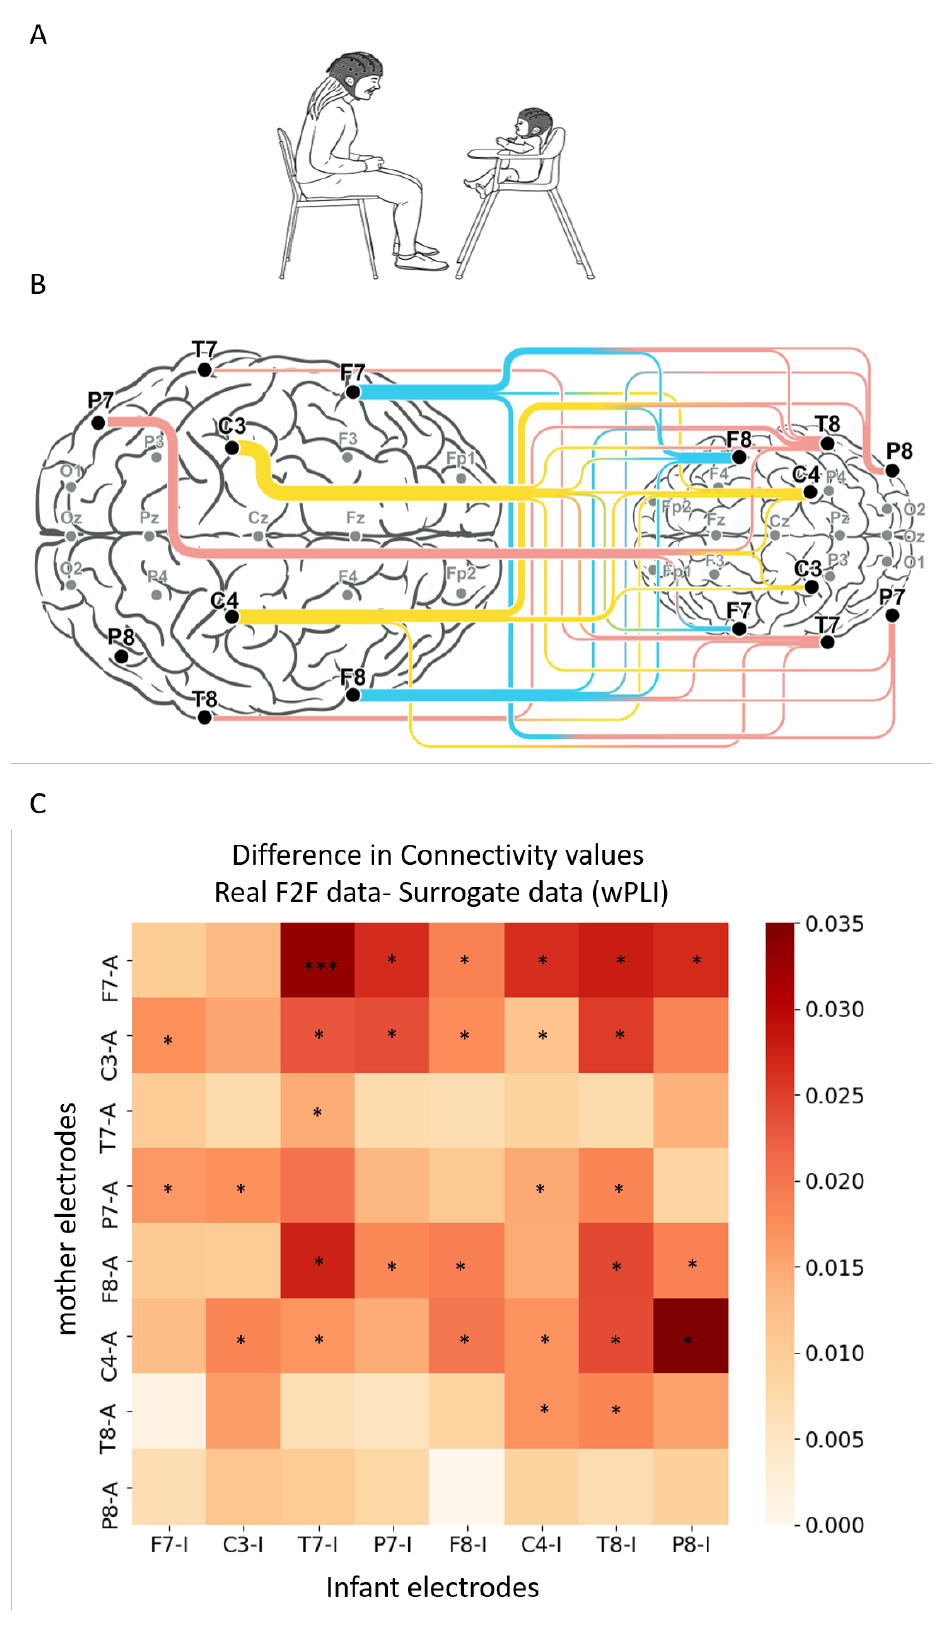
Figure 1. Difference in connectivity values for all electrode combinations between the real